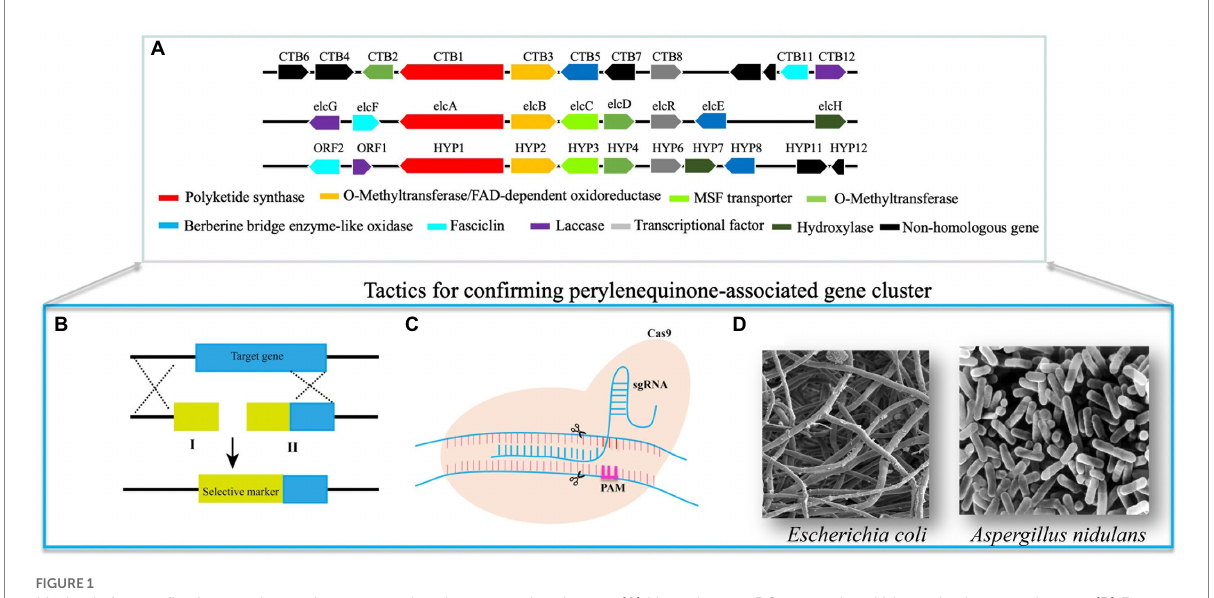
FIGURE 1 Methods for confirming perylenequinone-associated genes and pathways. (A) Homologous PQs-associated biosynthetic gene clusters. (B) For this split-marker approach, we need to synthesize two nucleotides fragment I and II. Fragments I comprise a partial selective marker and a sequence homologous to 5 ′ target locus; fragments II contain a partial selective marker and a sequence homologous to 3 ′ target locus. Thus, 5 ′ and 3 ′ homologous arms facilitate relevant homologous recombination of target genes and mutants can be screened on antibiotic regeneration plates due to the overlapping sequences of the selective marker of two fragments. (C) The CRISPR system contains two crucial elements, including Cas9 nuclease and sgRNA. The complex of these two elements precisely triggers double-strand breaks, induces cellular repair pathways, and results in relevant gene modification. (D) Verification of crucial PQs-associated genes by expressing them in the tractable microorganisms and then following chemical comparisons.